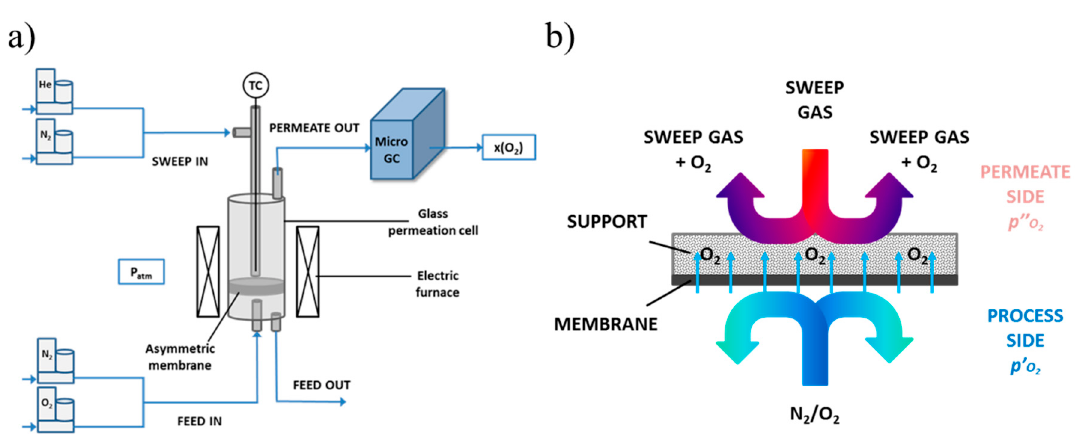
Figure 5. ( a ) Conceptual scheme of the experimental setup for high temperature O 2 permeation tests; ( b ) configuration of the supported membrane during permeation tests.